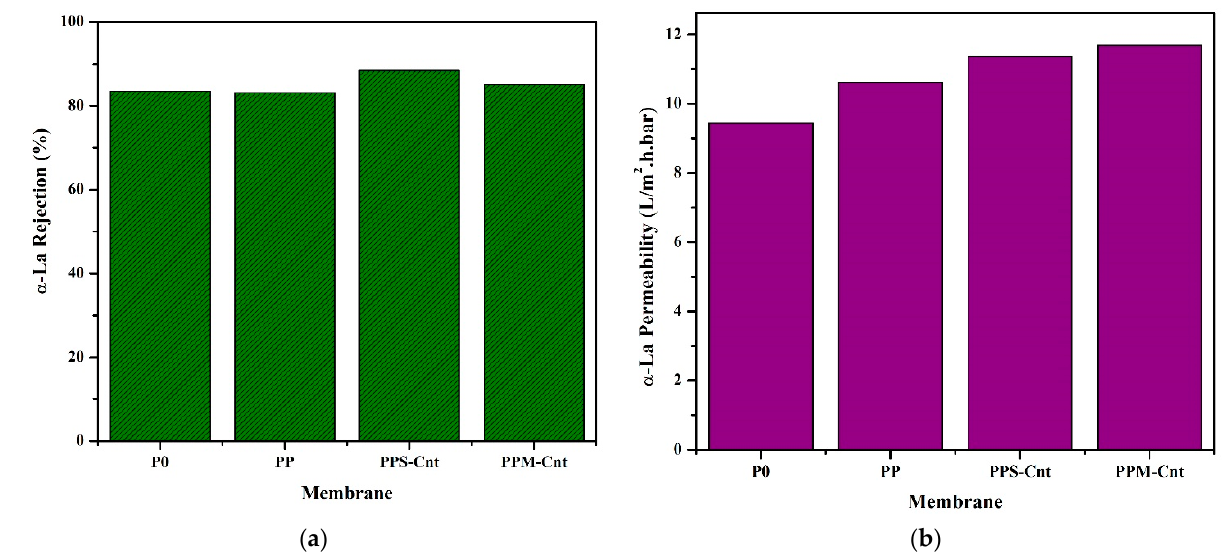
Figure 7. Filtration performance of the lactalbumin solution: ( a ) rejection and ( b ) permeability.